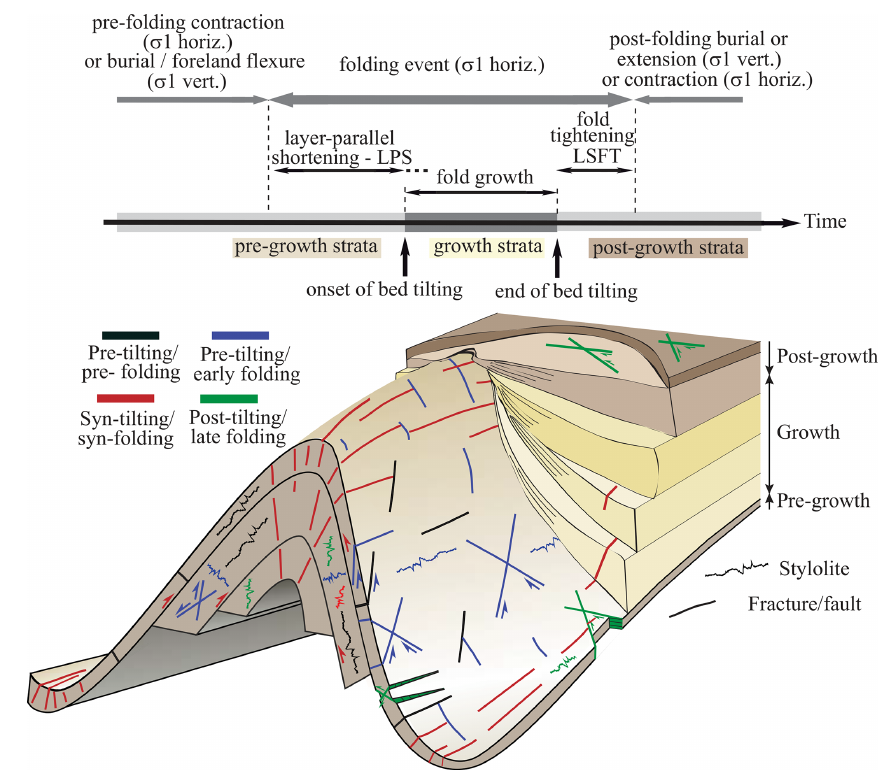
Figure 1. Concept of folding event and associated mesostructures and growth